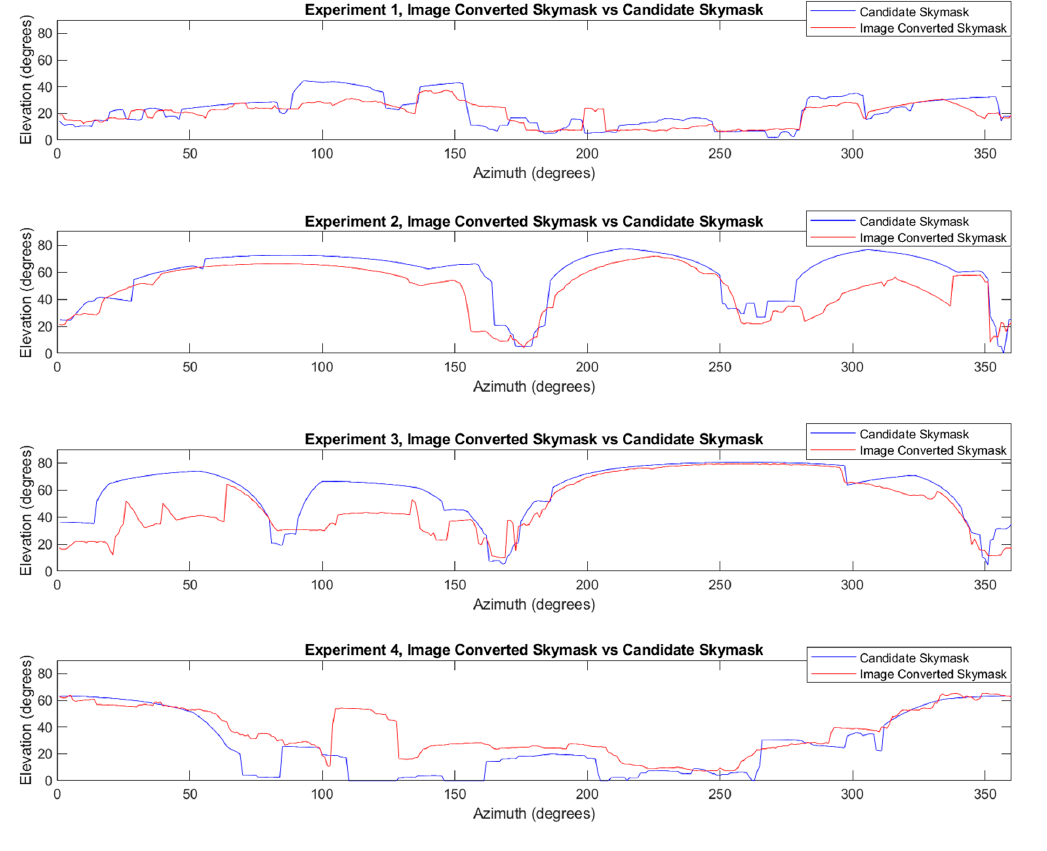
Figure 5. Azimuth and elevation comparison between the image ‐ converted skymask and predicted candidate skymask.